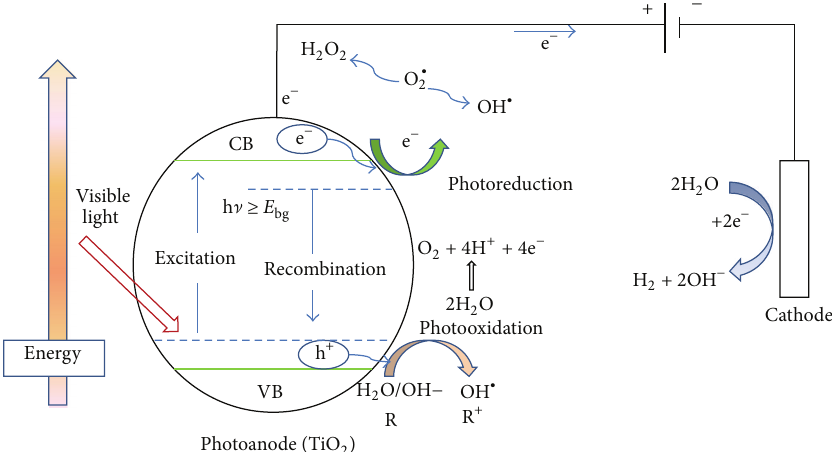
Figure 1: Mechanism of photoelectrocatalytic process using TiO 2 photocatalyst and the reactions that occur at the surface.